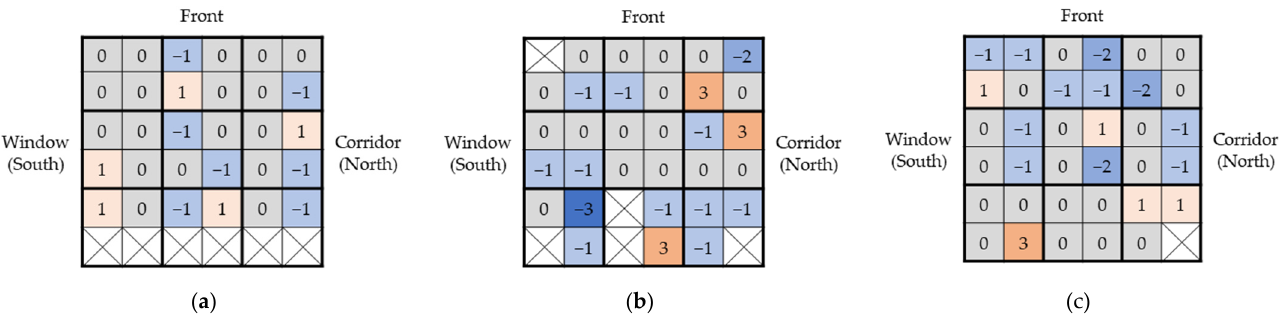
Figure 25. Summer TSV result per seating point in ( a ) class A, ( b ) class B, and ( c ) class C.